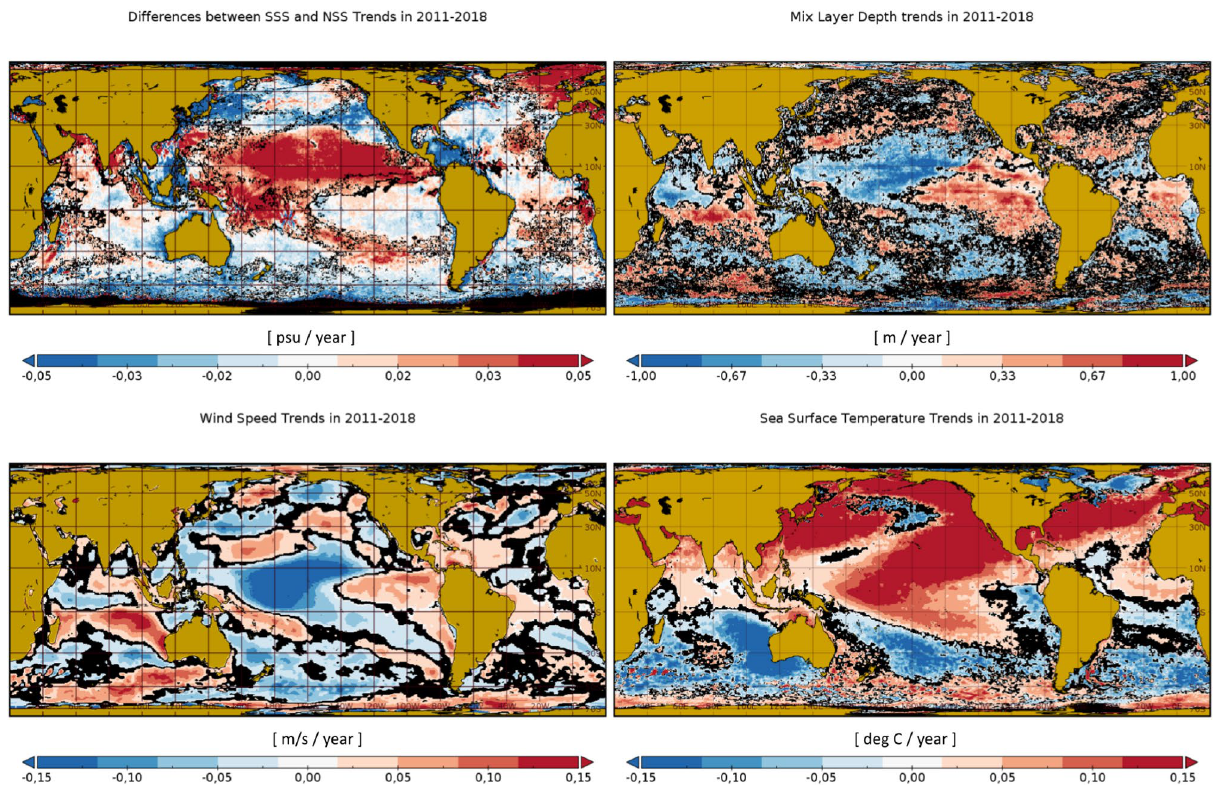
Figure 3. Top left panel: Differences between the satellite SSS trends and the model NSS trends in 2011–2018. Top right panel: mixed layer depth trends in 2011–2018. Bottom row: wind speed trends (left) and sea surface temperature trends in the same period (right). Locations with trends being different from zero with a 95% level of confidence are represented in black. Maps are plotted with Panoply v 4.12.0 (https:// www. giss. nasa. gov/ tools/ panop